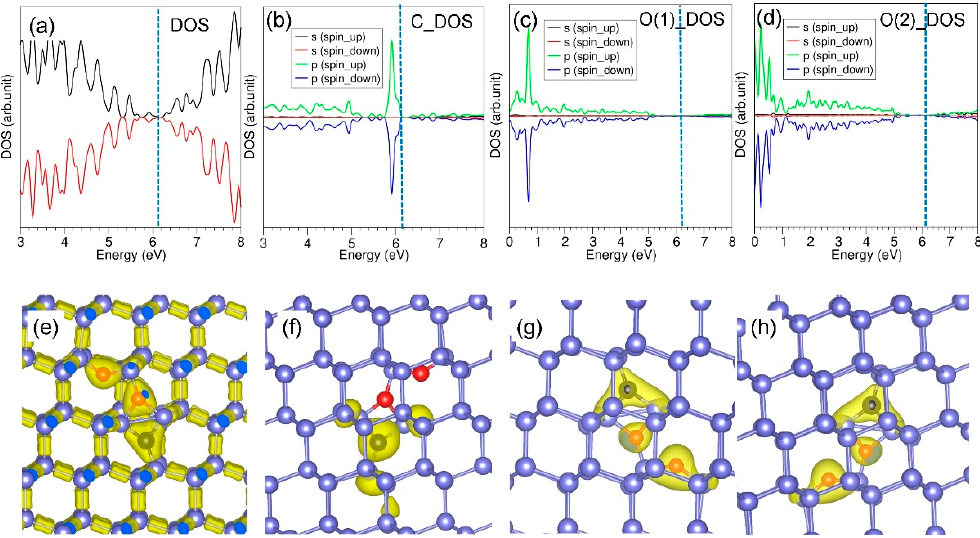
Figure 4. ( a ) Total DOS plot, ( b ) atomic DOS plot of carbon interstitial (C), ( c ) atomic DOS plot of the first oxygen interstitial (O(1)), ( d ) atomic DOS plot of the second oxygen interstitial (O(2)), ( e ) total charge density plot; decomposed charge density plots associated with ( f ) C, ( g ) O(1), and ( h ) O(2). Black circle refers to a carbon atom, and red circles refer to oxygen atoms.